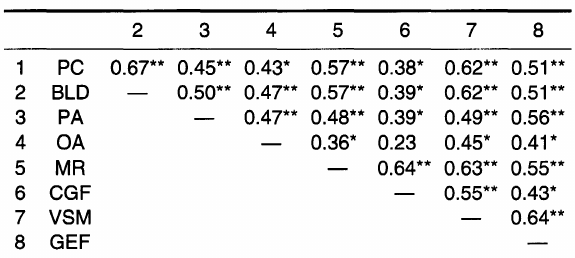
TABLE IV. Simple intercorrelations matrix of the eight tasks in the two groups of subjects (n = 54)